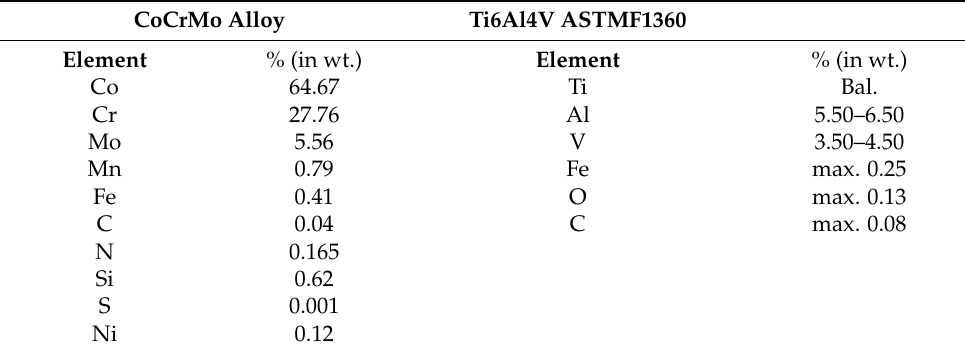
Table 1. Chemical composition (in wt.%) of CoCrMo and Ti6Al4V